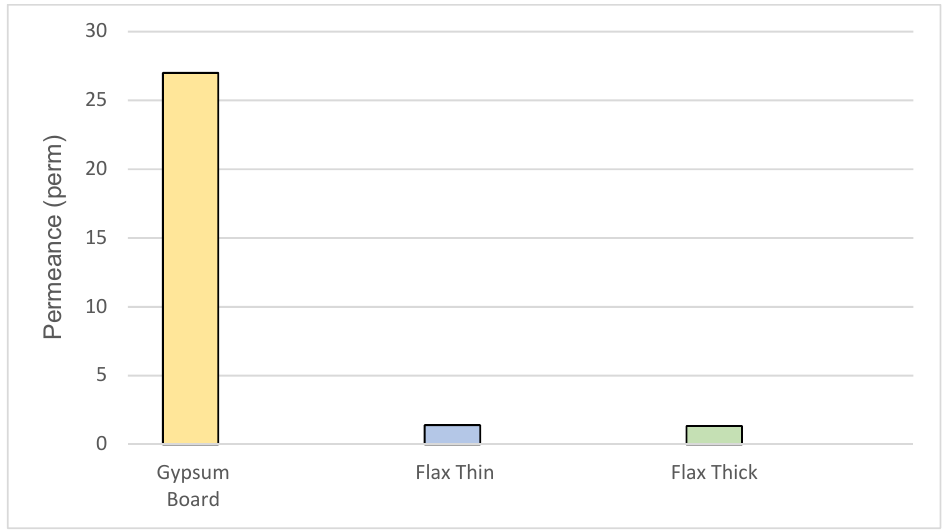
Figure 12. Average permeance of honeycomb structures.